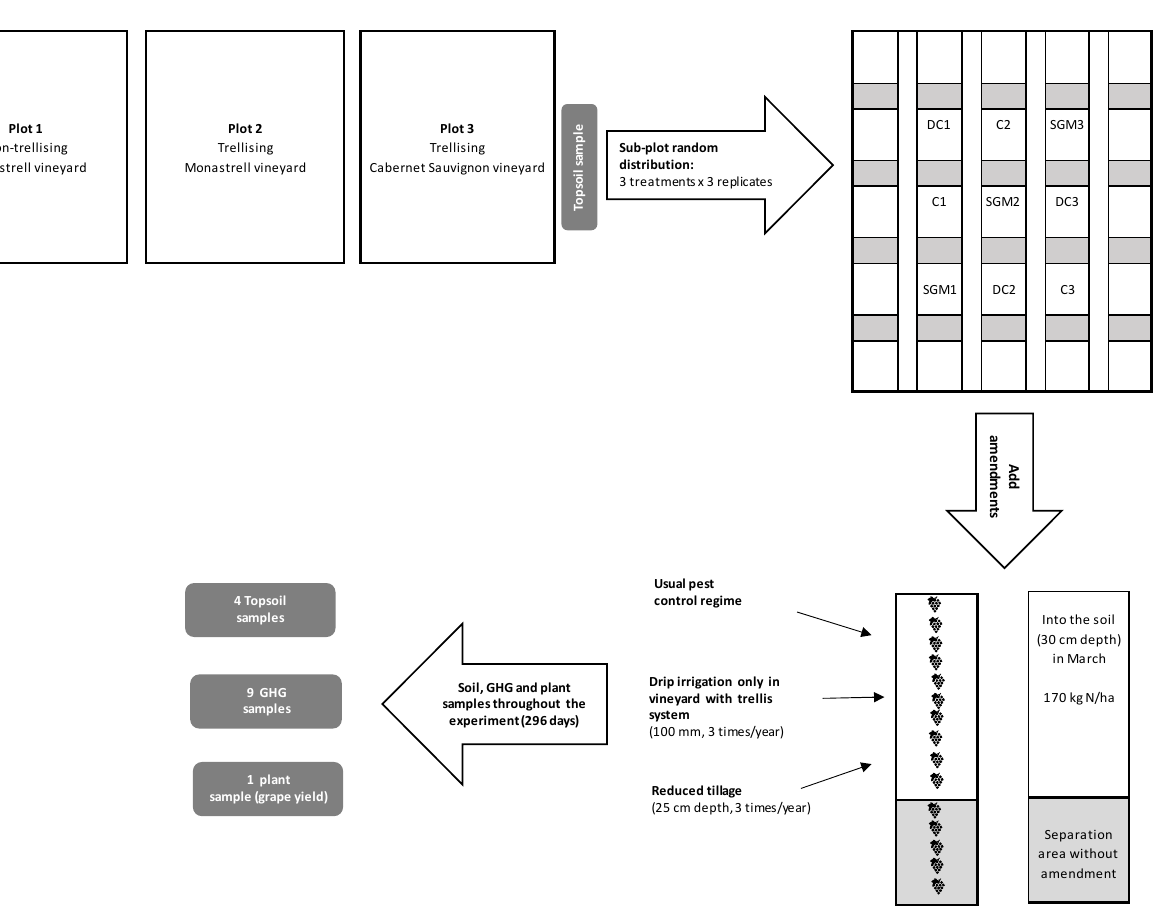
Table 1. Physico-chemical properties and chemical composition of the organic materials used in the experiment.